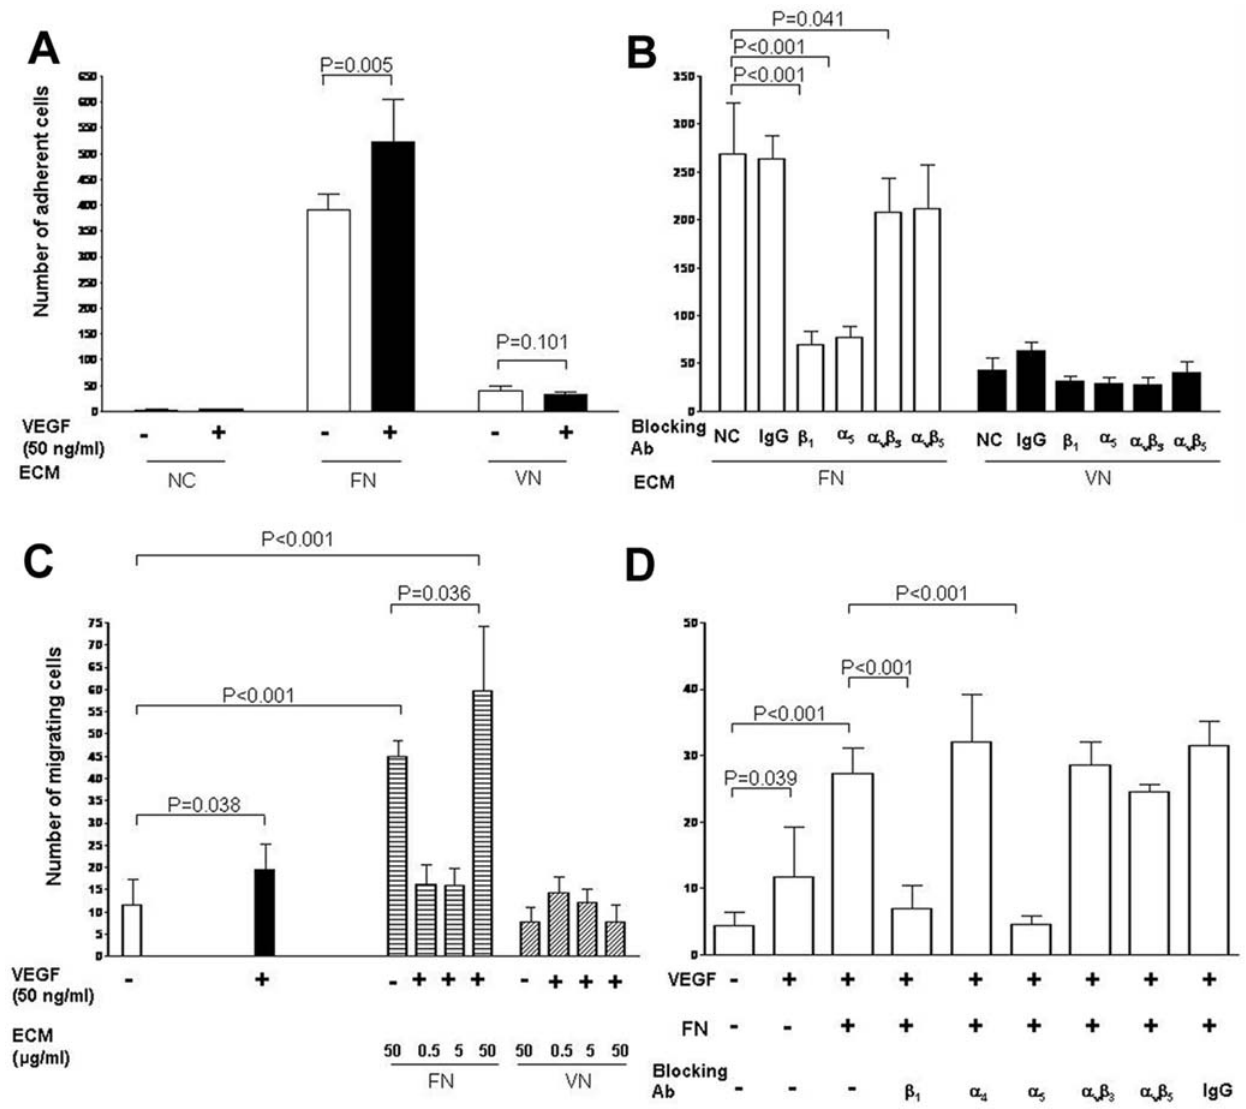
Figure 4. Adhesion and migration assays were performed with human placental multipotent mesenchymal stromal cells (hPMSCs) and various integrin-blocking antibodies. (A). hPMSCs were induced to differentiate into endothelial cells, then plated onto surfaces coated with BSA (NC), fibronectin, or vitronectin in the presence or absence of VEGF-A. The differentiated hPMSCs adhered to fibronectin more efficiently than to vitronectin (P , 0.001). VEGF-A significantly increased the adhesion of differentiated hPMSCs to fibronectin but not to vitronectin or plates coated with 2.5% BSA solution (NC). (B) Inhibition of differentiated hPMSC adhesion to fibronectin and vitronectin in the presence of blocking antibodies to integrin subunits. A significant inhibition of differentiated hPMSC adhesion to fibronectin was observed in the presence of blocking antibodies to integrin a 5 , b 1 or a v b 3 , but not integrin a v b 5 . The number of differentiated hPMSCs attached to vitronectin was low. (C) Transwell migration of differentiated hPMSCs induced by VEGF-A (50 ng/ml) with or without fibronectin (0.5 to 50 m g/ml) or vitronectin (0.5 to 50 m g/ml). Fibronectin in the presence of VEGF-A stimulated migration. (D) Inhibition of differentiated hPMSC transwell migration induced by VEGF-A (50 ng/ml) with or without fibronectin (50 m g/ml). Various blocking antibodies to integrin subunits and non-specific IgG were used. Antibodies to integrin subunits a 5 and b 1 were inhibitory. Error bar: SD; Ab: antibody; ECM: extracellular matrix.